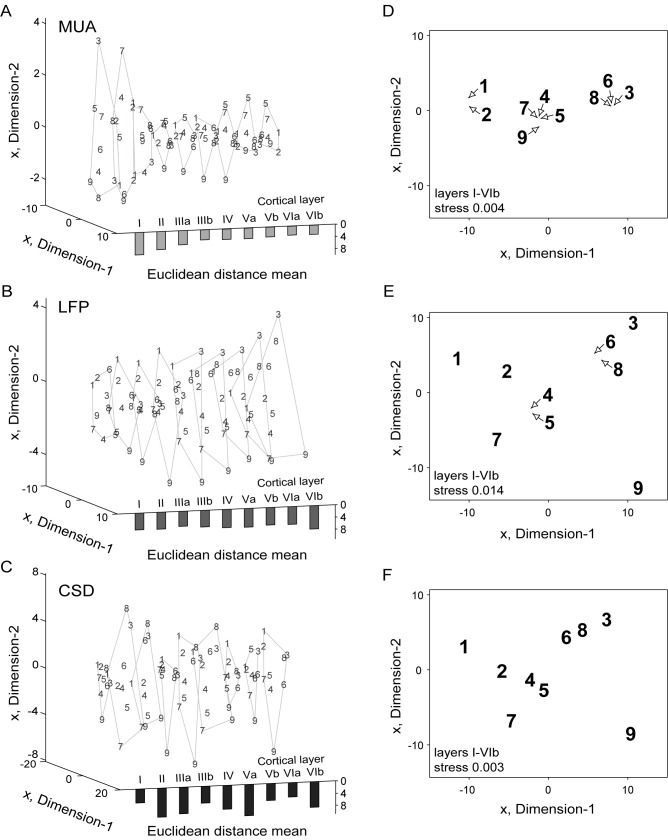
Multi-dimensional scaling (MDS) of averaged stimulus-evoked responses.Graphics display the two-dimensional MDS of the averaged responses of each layer (A-C) and the median MUA (D), LFP (E), and CSD (F) profiles of all layers. In (A-C) layers are indicated with Roman numerals. (A-F) Arabic numbers represent the stimuli eliciting the respective waveforms/profiles. (D-F) Arrows point to the actual position of profiles. Solid lines in the left graphics (A-C) indicate the outer borders of the layer-wise MDS. The mean of all Euclidean distances between the waveforms elicited by stimuli #1-#9 are displayed as bars at the bottom for each layer. The averaged waveforms or profiles were normalized to the respective stimulus-independent maximum value before calculation. The degree of dissimilarity between LFP and CSD waveforms/profiles is increased in comparison to the MUA. The whole laminar profiles segregate 2.3 (MUA), 2.6 (LFP), or 1.8 (CSD) times better across different calls than single-layer activity.